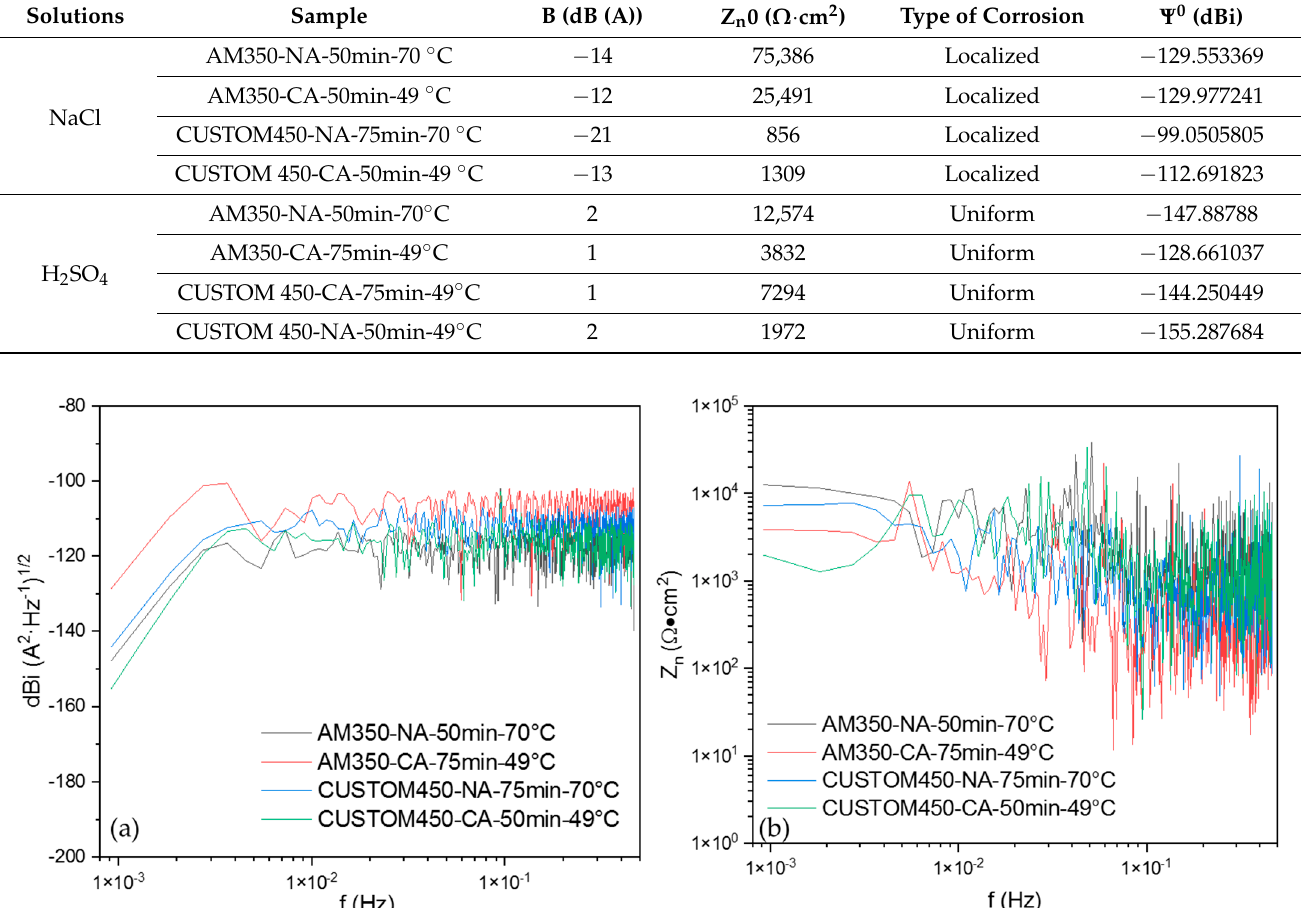
Table 5. Parameters obtained by PSD.